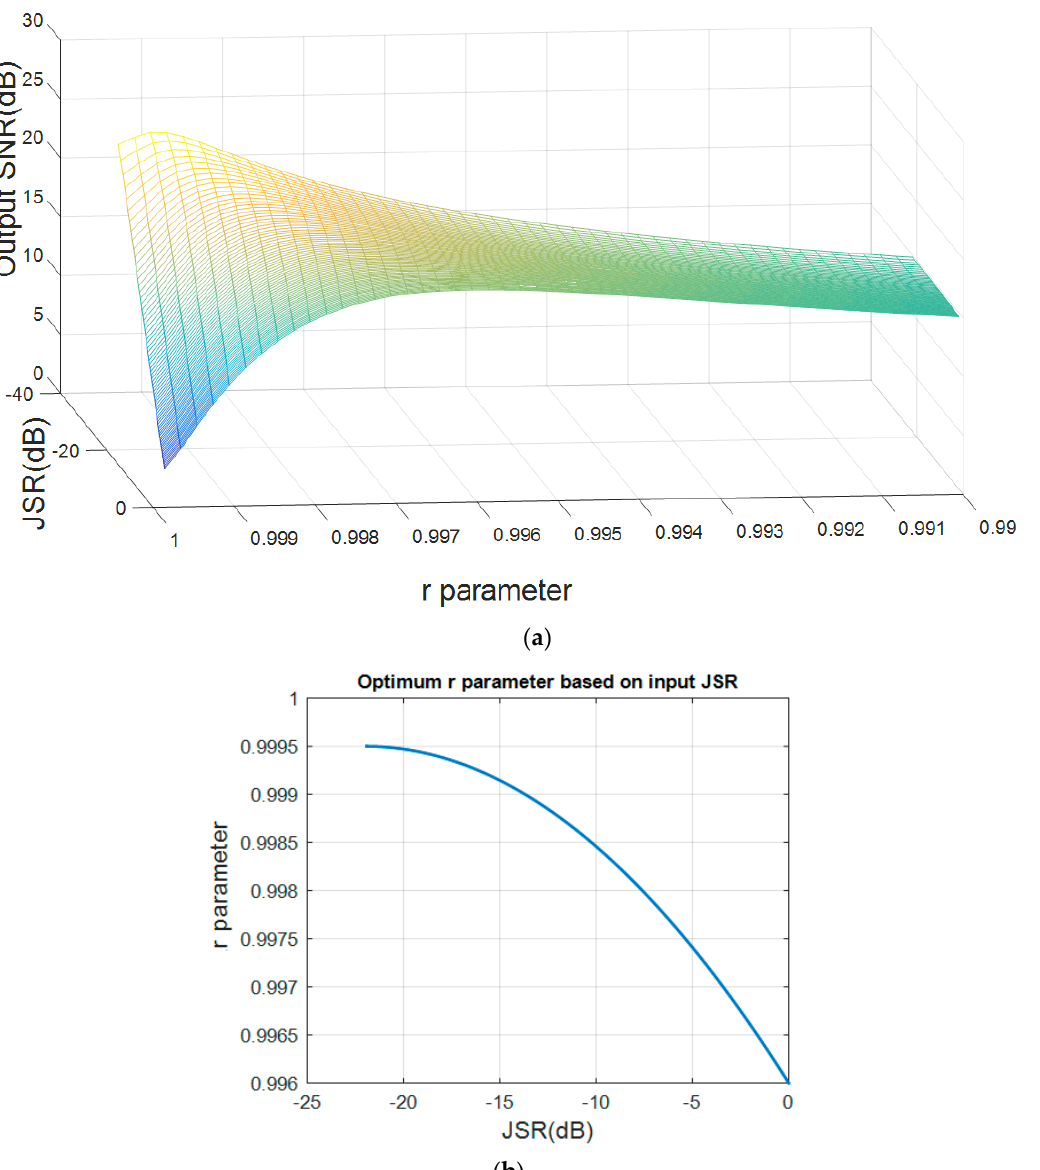
Figure 10. Optimum r parameter selection based on the input Jamming to Signal Ration (JSR); (a) Three dimentional Figure 10. Optimum (cid:1870) parameter selection based on the input Jamming to Signal Ration (JSR); ( a ) Three dimentional representation; ( b ) Optimum r based on the input JSR representation; (b) Optimum r based on the input